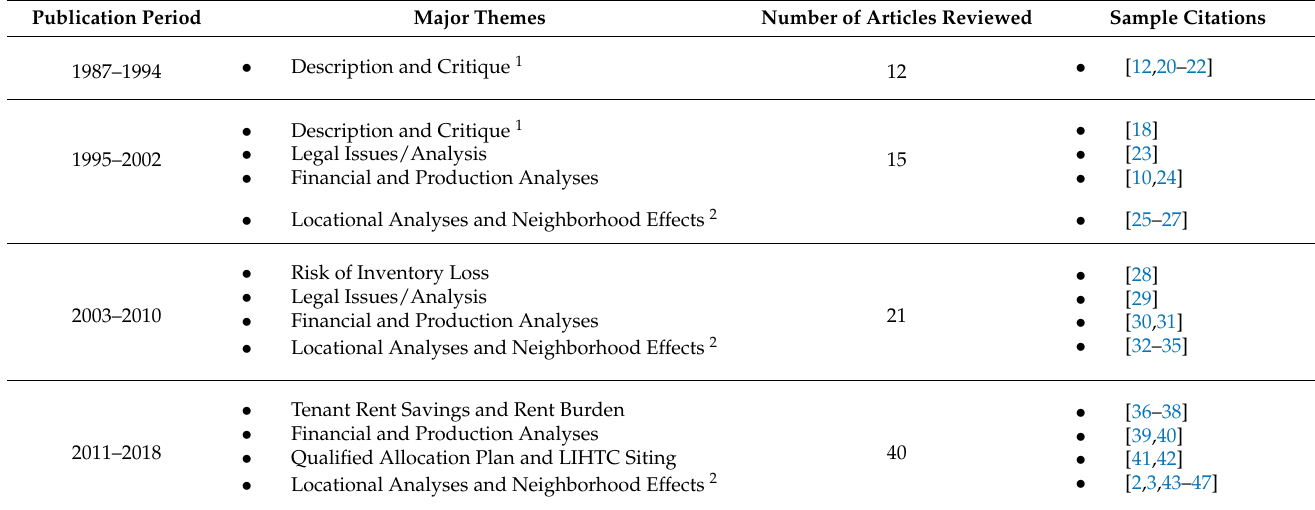
Table 1. Sample of Contributions to the LIHTC Literature Over